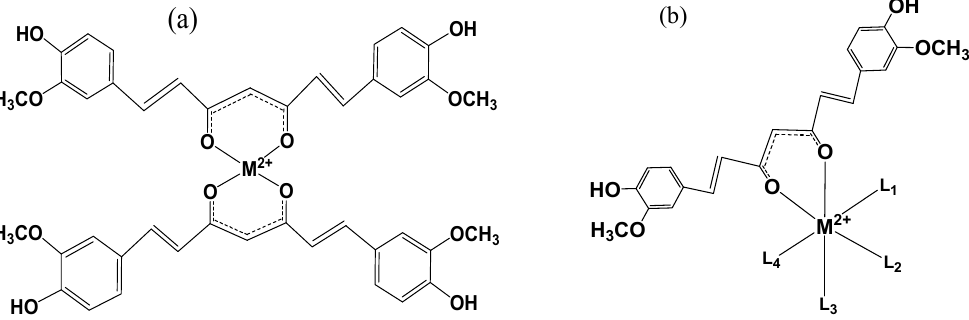
Figure 1. ( a ) Structure of 2:1 curcumin:metal complex; ( b ) Mixed ligand curcumin:metal